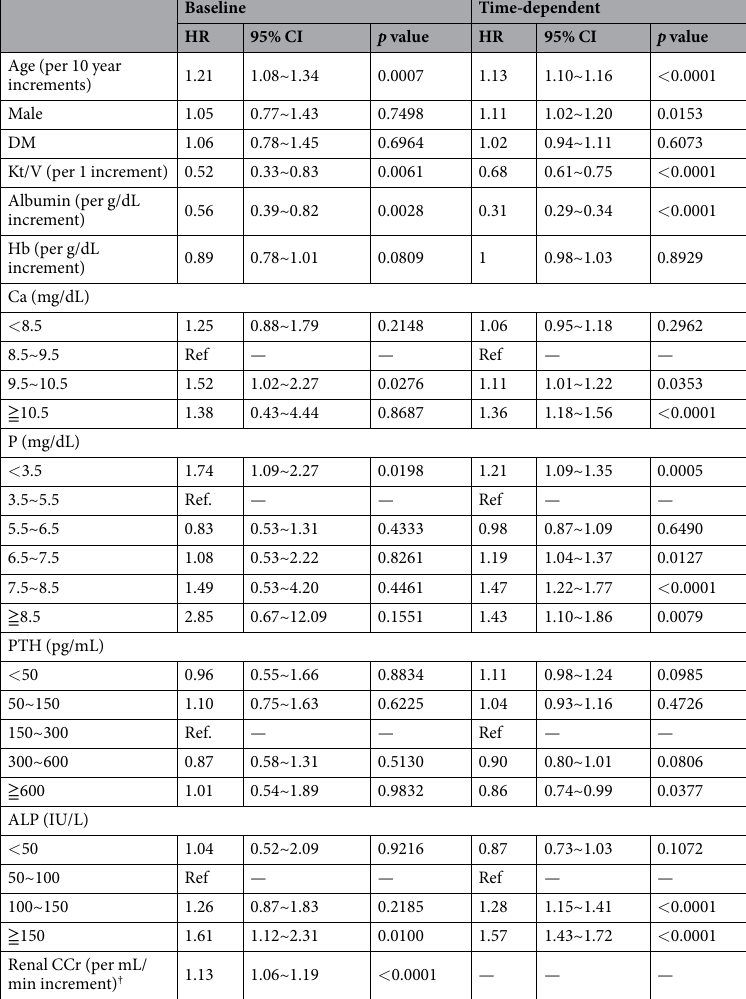
study with repeated measurements, time-dependent analyses theoretically provide a more appropriate evaluation of the association between the time-varying covariates and outcomes. The majority of observational studies conducted in HD patients have shown that serum phosphorus and cal- cium levels either higher or lower than the normal limits are associated with a higher risk of mortality, depicting U-shaped relationships 27–31 . Noordij et al . 17 , in a prospective cohort study involving 586 PD patients, demon- strated that serum phosphorus levels higher than the normal upper limit, but not abnormal calcium or PTH levels, were associated with increased mortality. Similarly, in another prospective cohort study involving 515 dialysis patients (including 158 PD patients) conducted by Stevens et al . 16 , only serum phosphorus (not calcium or PTH) showed significant association with mortality. In the present study, conducted exclusively in PD patients, time-dependent analyses showed that serum calcium levels ≧ 9.5 mg/dL, but not hypocalcemia, was significantly associated with increased mortality. This suggests a deleterious effect of higher serum calcium levels on the sur- vival of patients on PD. In addition, the results of the present study showed that the effect of serum phosphorus on mortality depicted a U-shaped relationship. While the time-dependent analysis showed increased mortality with serum phosphorus levels ≧ 6.5 mg/dL, phosphorus levels < 3.5 mg/dL were consistently associated with increased mortality in statistical models using either baseline or time-varying variables. This may suggest that malnutrition has a strong detrimental effect in patients on PD, regardless of its duration. The relationship between PTH and mortality in dialysis patients has also been inconsistent across multi- ple studies. While some studies have shown that higher PTH is associated with decreased risk of mortality 3–7, 9 , others have conversely suggested an increased risk of mortality 10, 32 . In addition, several studies have shown a U-shaped relationship 5, 27–29, 31 or no significant association 1, 2, 8, 33 between PTH and mortality. In a prospective